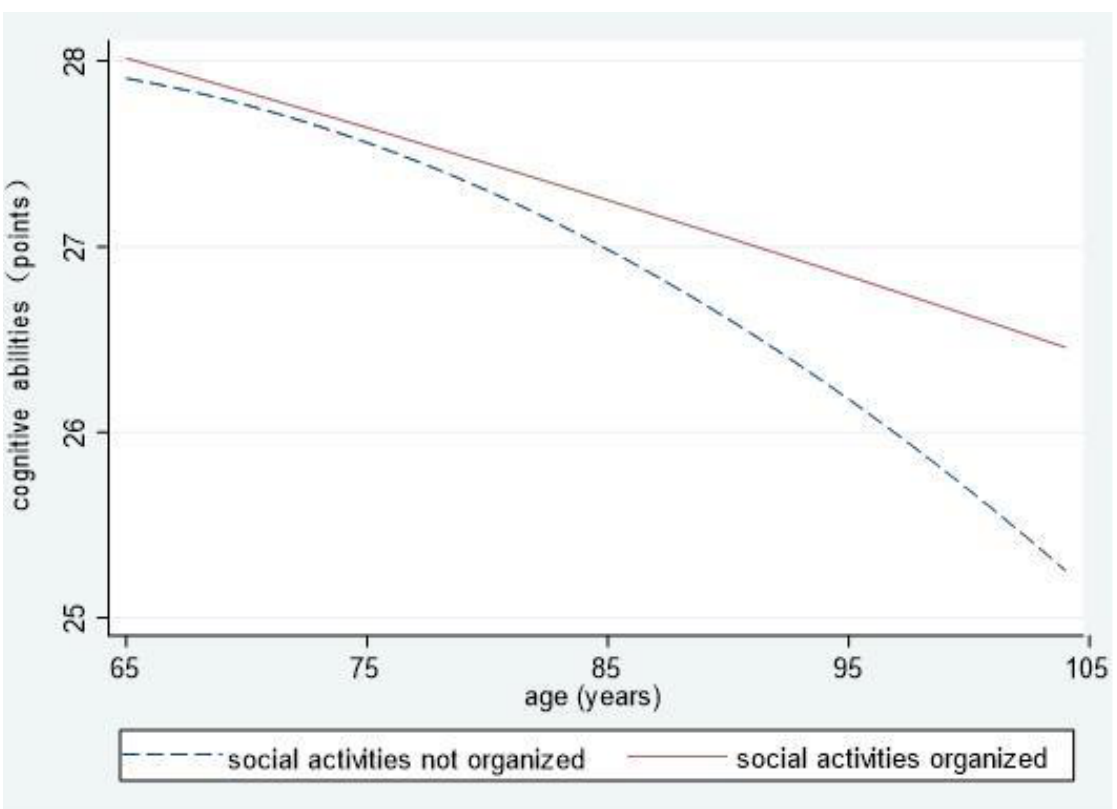
Figure 2. The influences of communities organizing social activities on cognitive abilities.